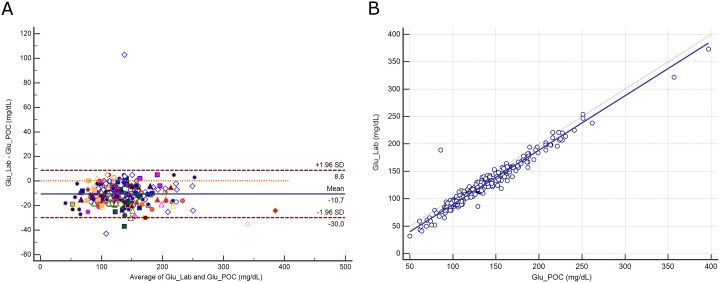
5A. Bland-Altman plot showing the difference versus the average of glucose (Glu) measured by the central Lab analyzer and by the POC Siemens RAPIDPoint 500 blood gas system. Bias, upper and lower limits of agreement (±1.96 SD) are represented. The red dotted line indicates equality (difference = 0). There is one marker for each patient. 5B. Scatter diagram showing Deming regression analysis for glucose (Glu) measured by the central Lab analyzer and by the POC Siemens RAPIDPoint 500 blood gas system. The regression line (solid line) and the identity line (x = y, dotted line) are represented.